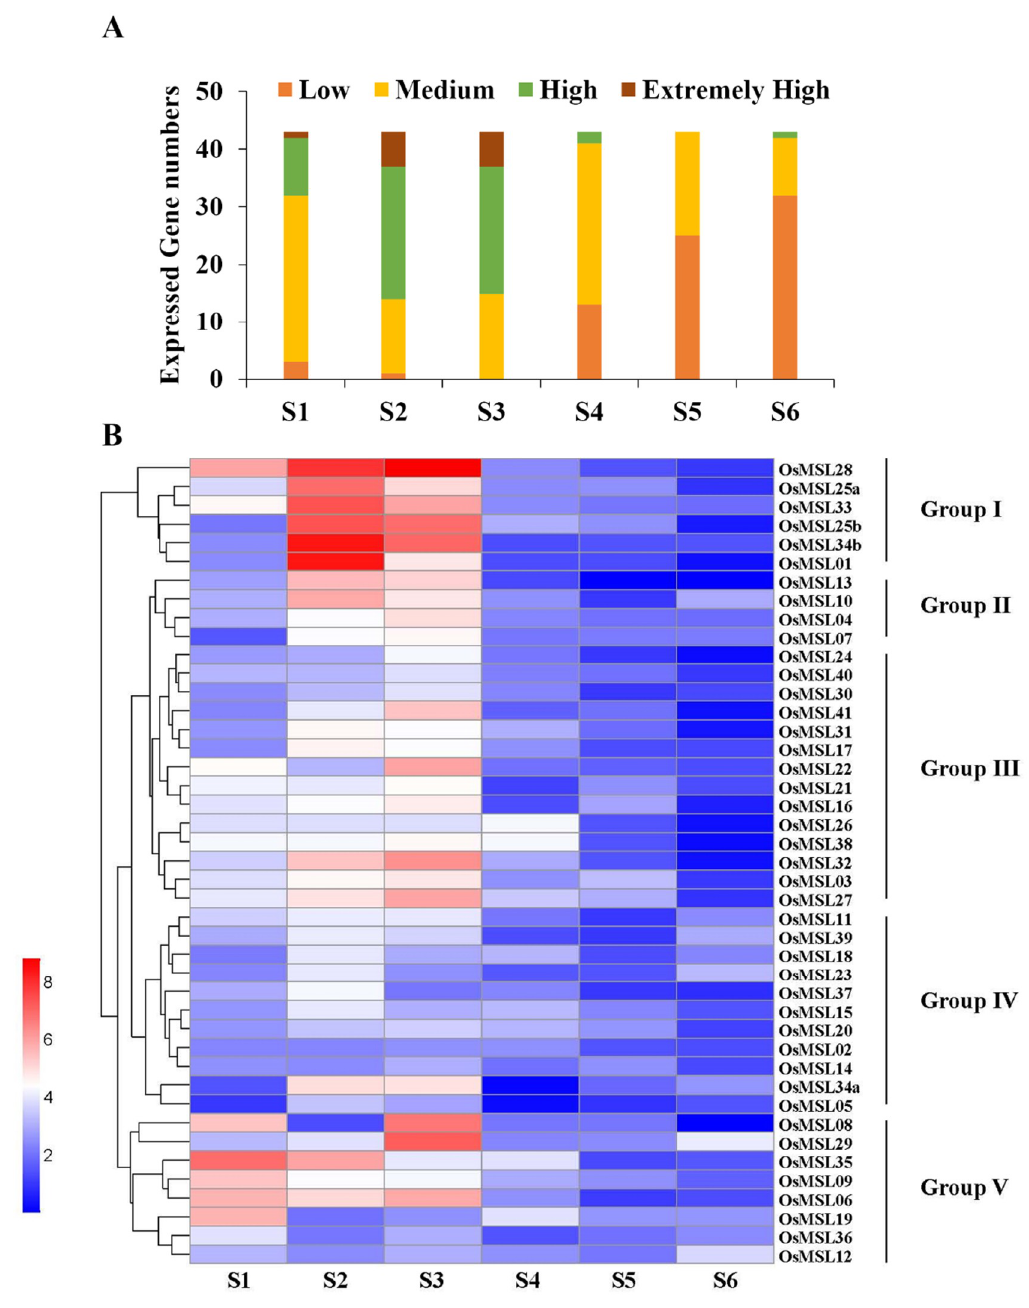
Figure 9. Expression of the rice trihelix gene family at different developmental stages (S1: 7 days after sowing; S2: 20 days after sowing; S3: 40 days after sowing; S4: 80 days after sowing; S5: 100 days after sowing; S6: 140 days after sowing). ( A ) Numbers of expressed genes in various developmental stages. Expression data of the rice trihelix gene family genes were retrieved from the Expression Atlas database. Extremely high: Expression value > 6, high: 6 ≥ expression value > 4, medium: 4 ≥ expression value > 2, low: 2 ≥ expression value > 0; ( B ) Expression patterns of trihelix genes in various rice developmental stages. Heatmaps were created in HemI v.1.0 and based on the expression data. Expression levels are depicted by different colors on the scale. Blue and red represent low and high expression levels, respectively.